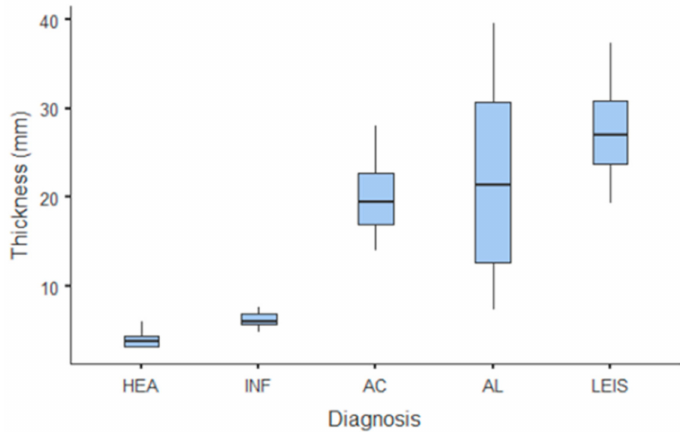
Figure 1. Box and whisker plot of the gastric wall thickness for healthy (HEA), inflammatory (INF), adenocarcinoma (AC), lymphoma (AL), and leiomyosarcoma (LEIS). Table 1. Wall thickness B-mode evaluation for healthy (HEA), inflammatory (INF), adenocarcinoma (AC), lymphoma (AL), and leiomyosarcoma (LEIS) reported as means with standard deviations ( ± SD) and ranges. Wall Thickness HEA INF AC AL LEIS (mm)